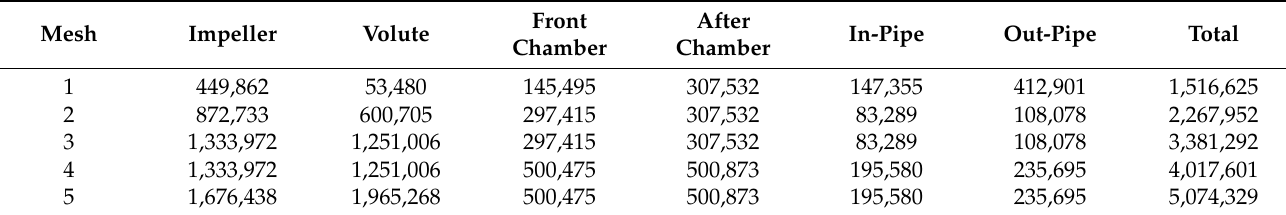
Table 2. Distribution of the grid numbers in each domain.